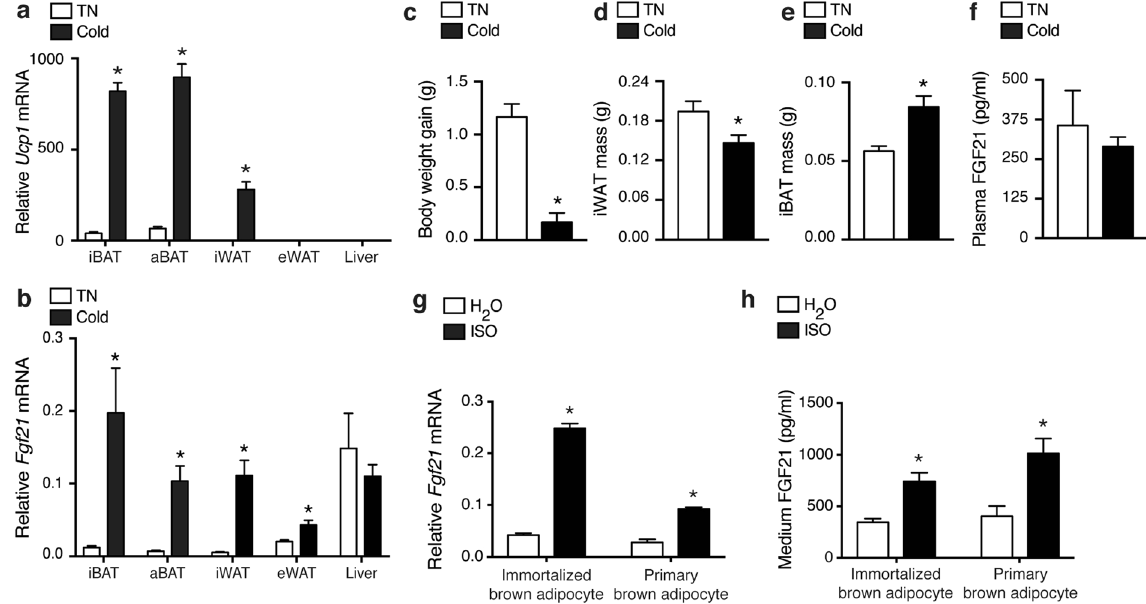
Figure 1. FGF21 expression and secretion is under β -adrenergic control in brown adipocytes. Ten weeks old male C57BL/6JBomTac mice were housed at 29 °C (thermoneutrality, TN) or 4 °C (cold) for 4 days. Relative mRNA levels of Ucp1 ( a ) and Fgf21 ( b ) in various tissues. Cold exposure effect on average body weight gain during the 4-day period ( c ), iWAT wet weight ( d ) iBAT wet weight ( e ) and plasma concentration of FGF21 ( f ). ( g ) Expression of Fgf21 in immortalized or primary brown adipocytes treated with 0.1 μ M isoproterenol (ISO) for 6 h. ( h ) Secreted FGF21 in cell culture medium from immortalized or primary brown adipocytes treated with 0.1 μ M ISO for 24 h. Data represent mean + SEM (n = 6, mice) or mean of means + SEM (n = 3, cell culture). Unpaired two-tailed Student’s t-test was applied in all panels. * p < 0.05 versus TN/H 2 O